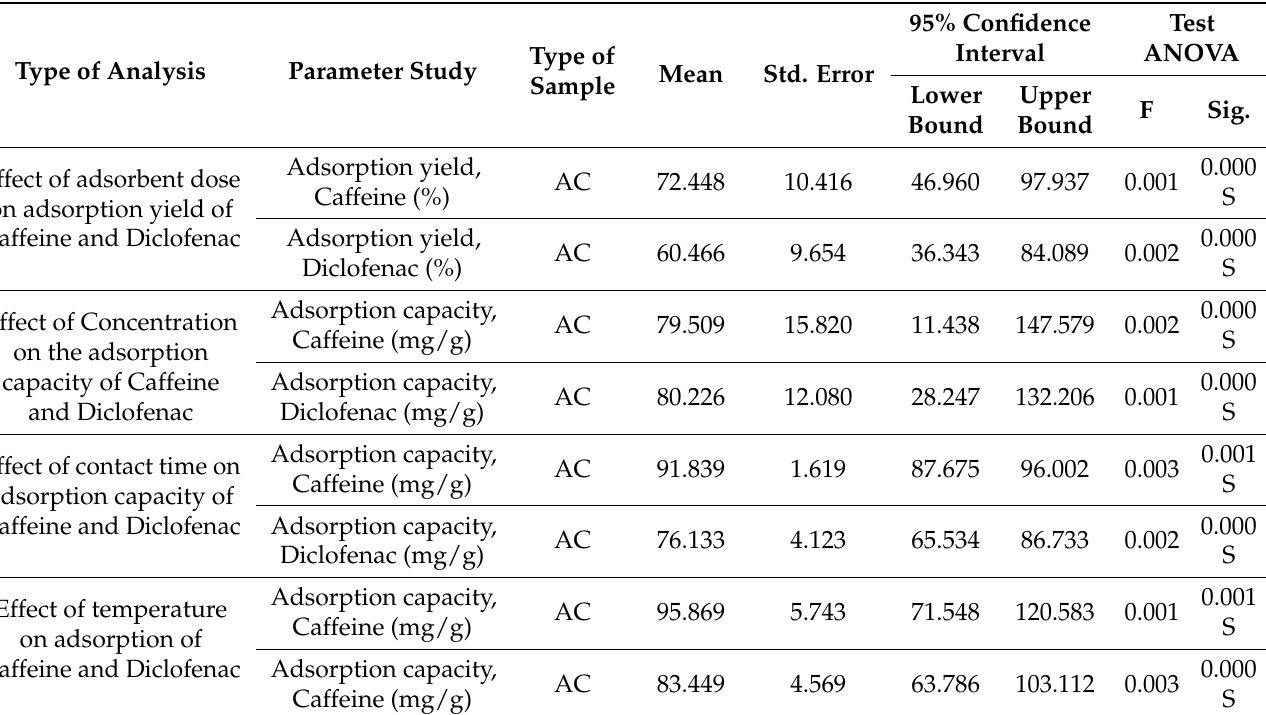
Table 8. Analysis of variance (F-test) of the effects on the adsorption of caffeine and diclofenac by the activated carbons from argan nutshells